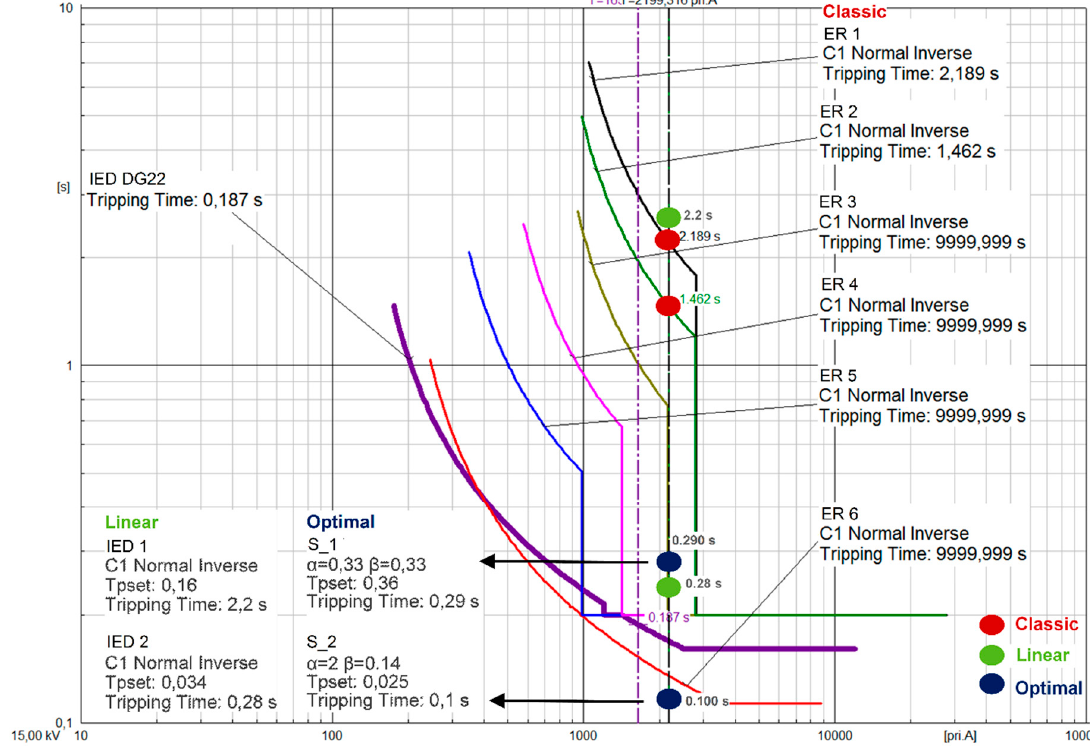
Figure 8. Tripping time comparison of the three protection schemes (classical, linear, and optimal smart-sensor coordination) for Scenario B